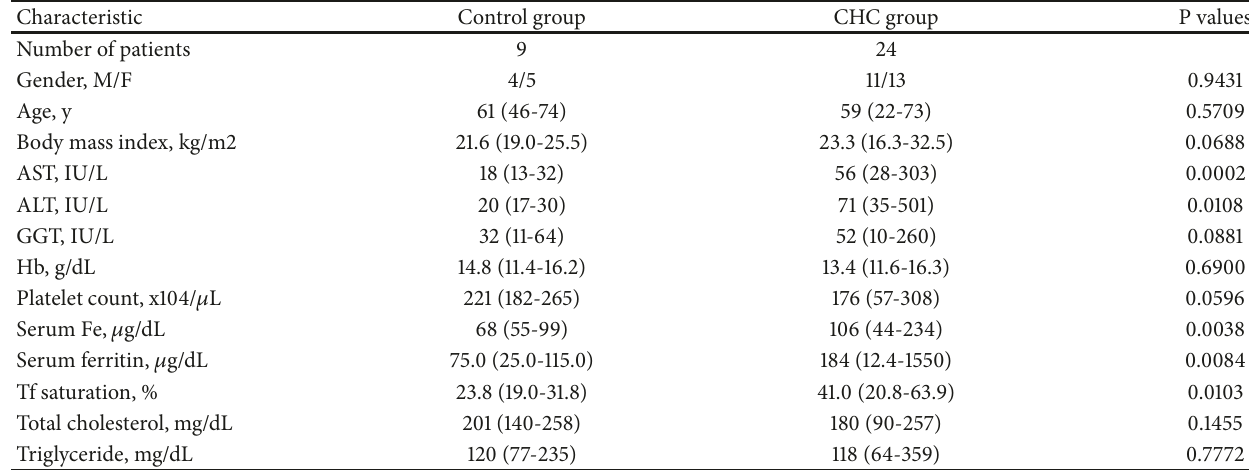
Table 1: Baseline characteristics of study